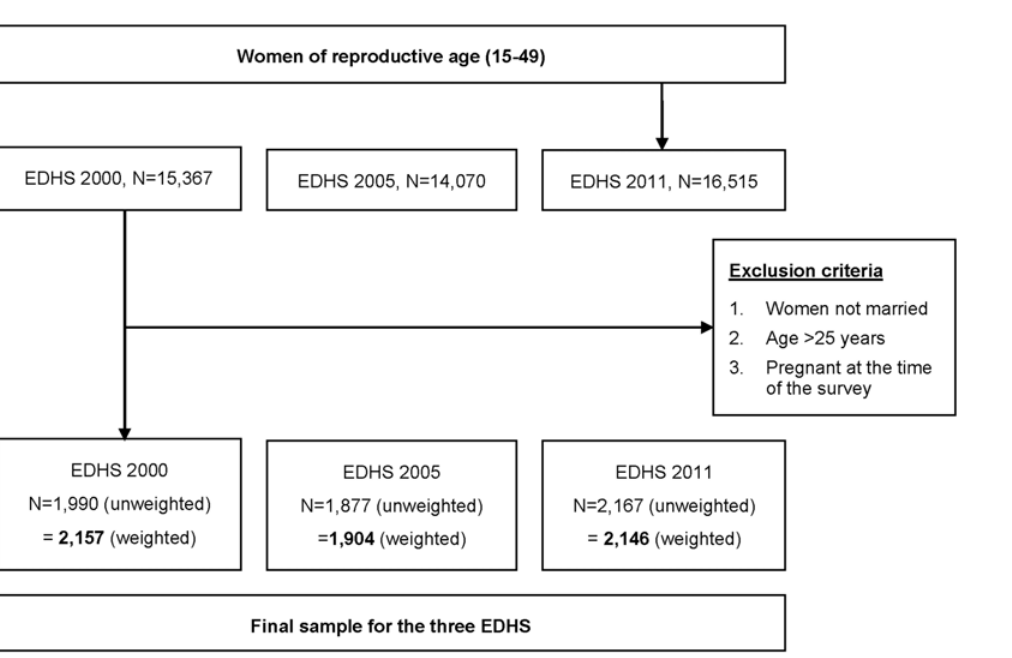
Figure 2. The exclusion procedures to identify the final sample size in DHS 2000, 2005, and 2011.